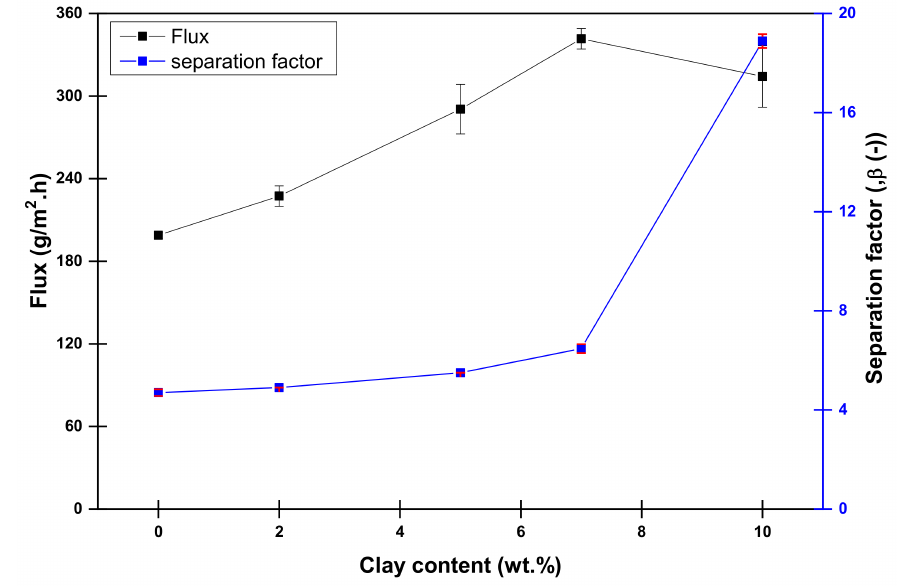
Figure 2. Dehydration performance of the PVA membrane and laponite mixed matrix membranes (MMMs) at 40 ◦ C using 85 wt% MeOH as feed